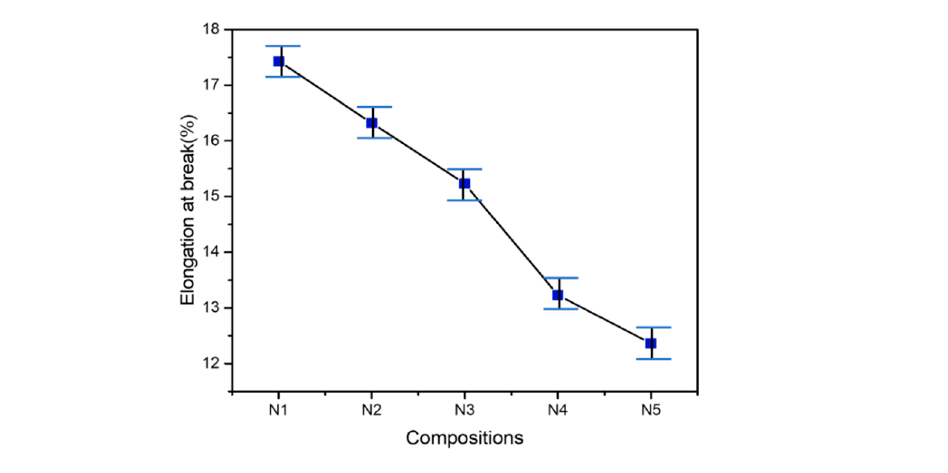
Figure 7. Elongation at break (%) of PLA-PBS-CNC nanocomposites at varying percentages of CNC. The PLA-PBS has typically high tensile strength, tensile modulus and elongation at break. Similar results were reported in some previous works [23,58]. CNCs’ effect